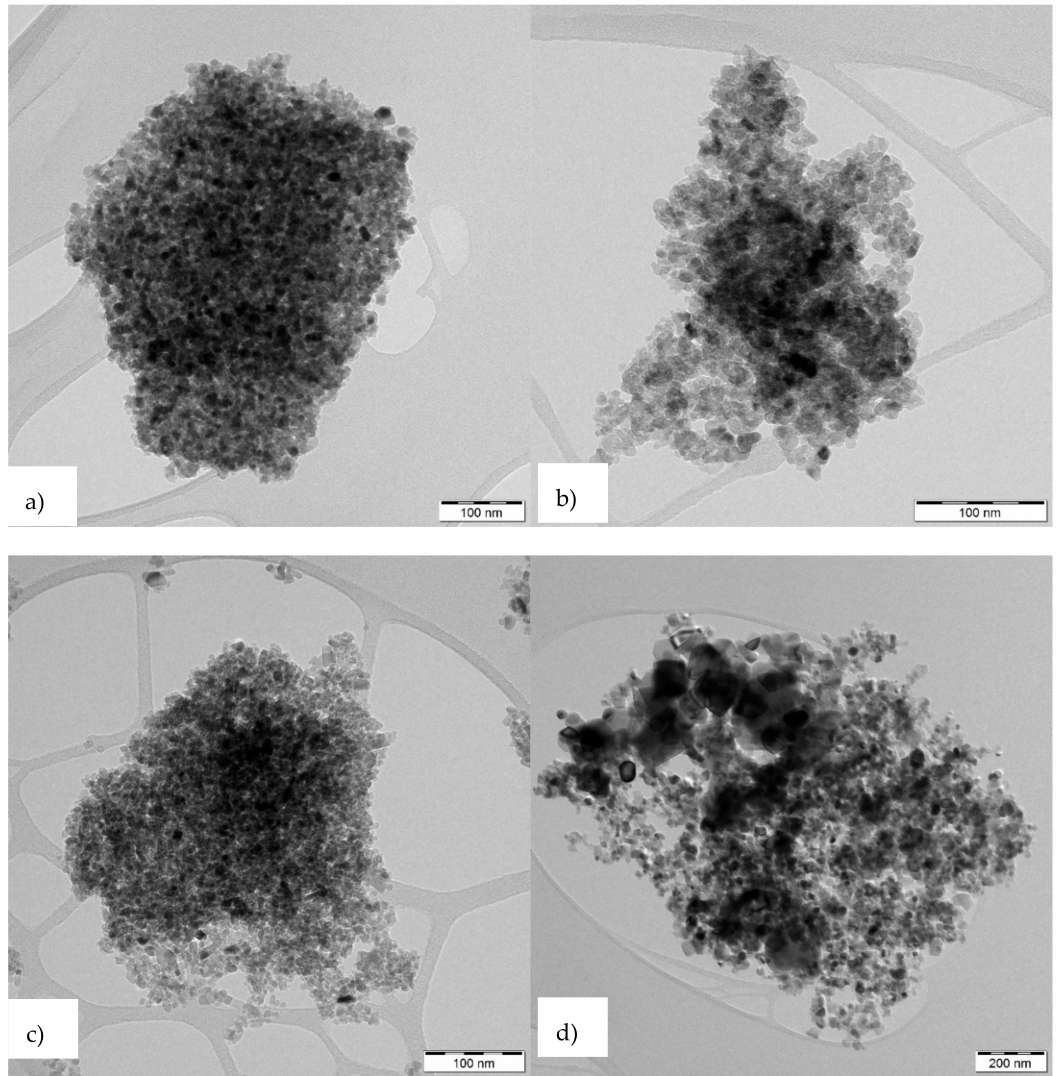
Figure 4. TEM images of ( a ) TiO 2 –ISOP–C / 400; ( b ) TiO 2 –TYS–C / 450; ( c ) TiO 2 –ISOP–PFC; ( d ) TiO 2 –P25.